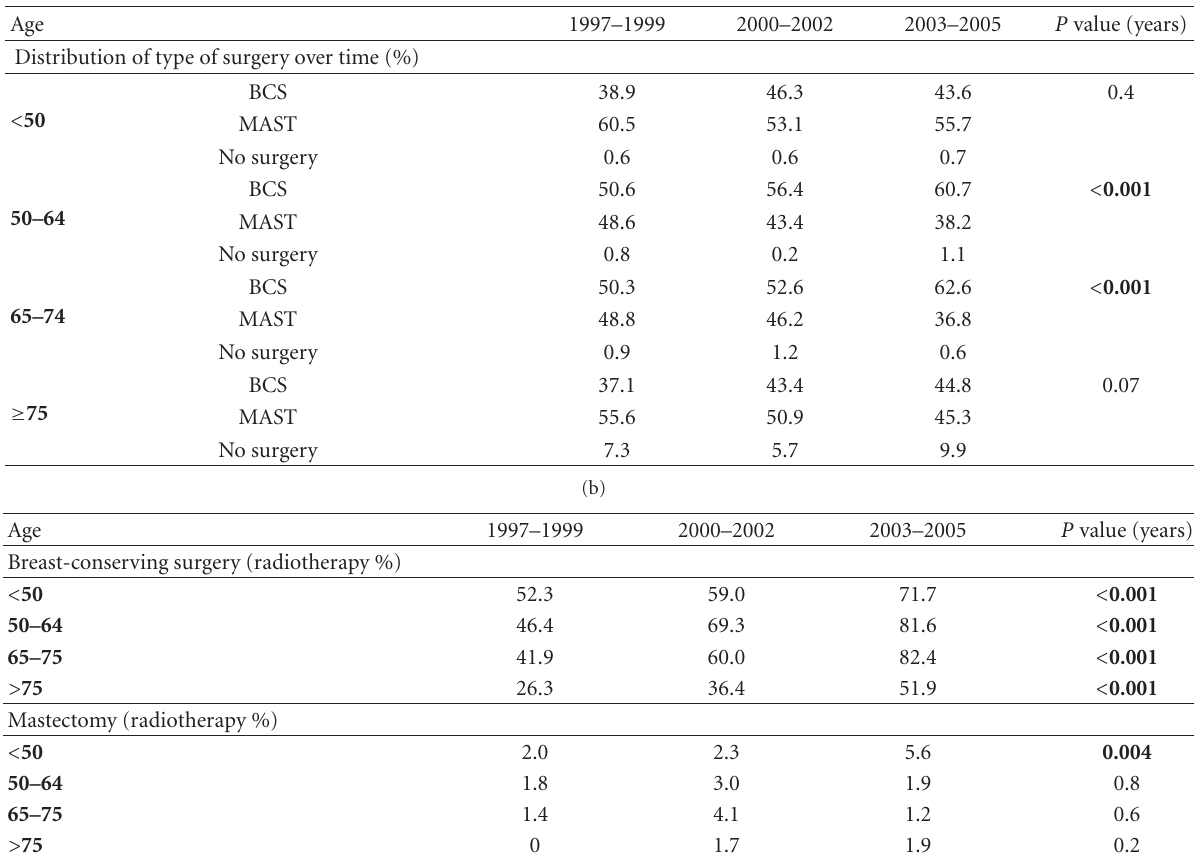
(a) SurgicaltreatmentforDCISovertimeintheNetherlands.(b)Adjuvantradiotherapy,overtime,forpatientswithDCISundergoingbreastconserving surgery (BCS) or